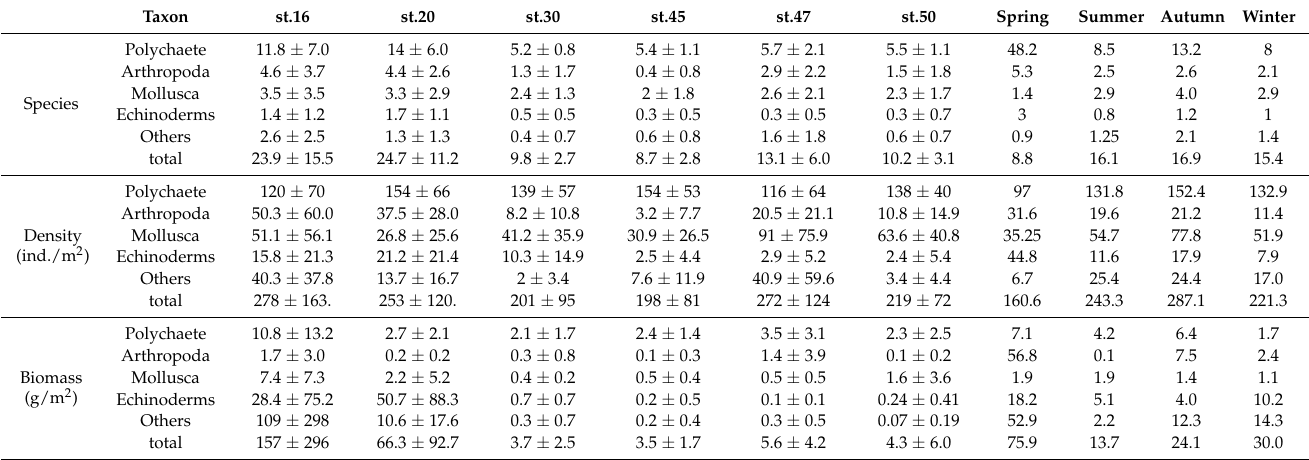
Table 2. Macrobenthos species number, density (individuals/m 2 ), and biomass (g/m 2